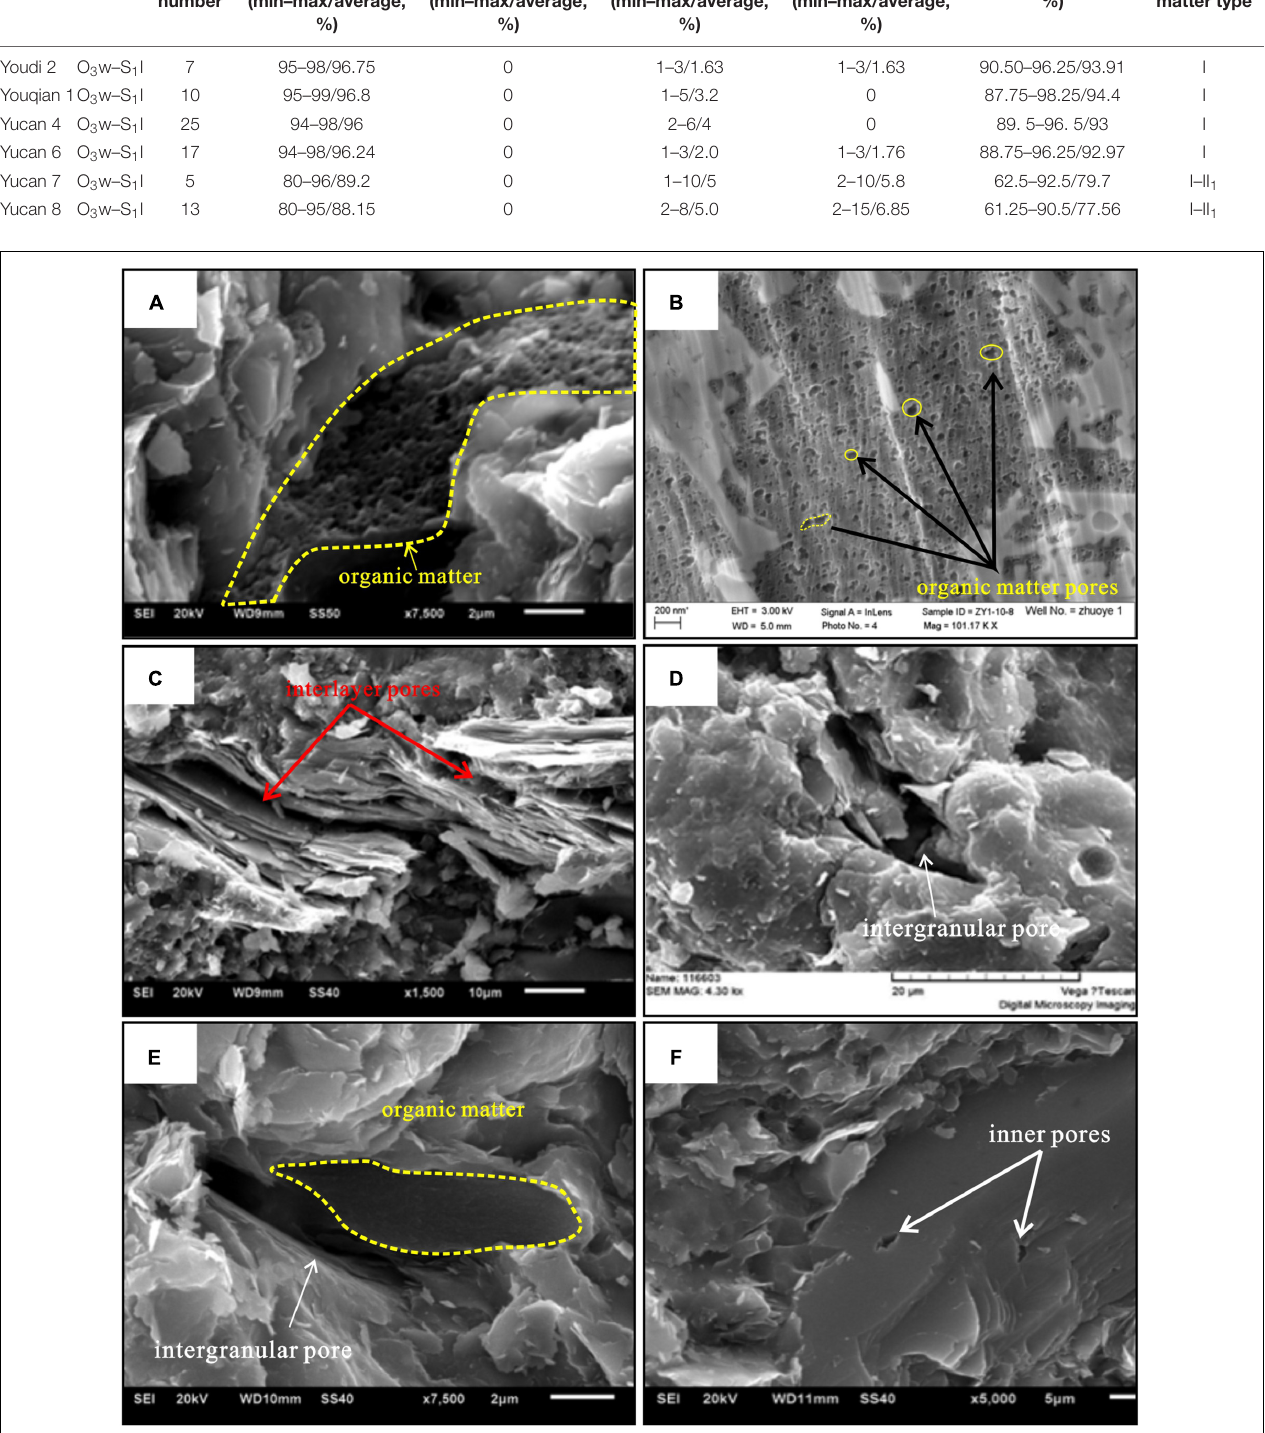
FIGURE 4 | Types and characteristics of pore spaces of the Longmaxi Formation shale in the study area (scanning electron microscopy). (A) Nano-scale organic pores, Yucan 4 well; (B) nano-scale organic pores, Zhuoye 1 well; (C) interlayer pores of clay minerals, Youdi 2 well; (D) intergranular pores, Qianqian 1 well; (E) micron-scale organic matter and mineral intergranular pores, Yucan 6 well; (F) nano-scale feldspar grain inner pores, Yucan 6 well.